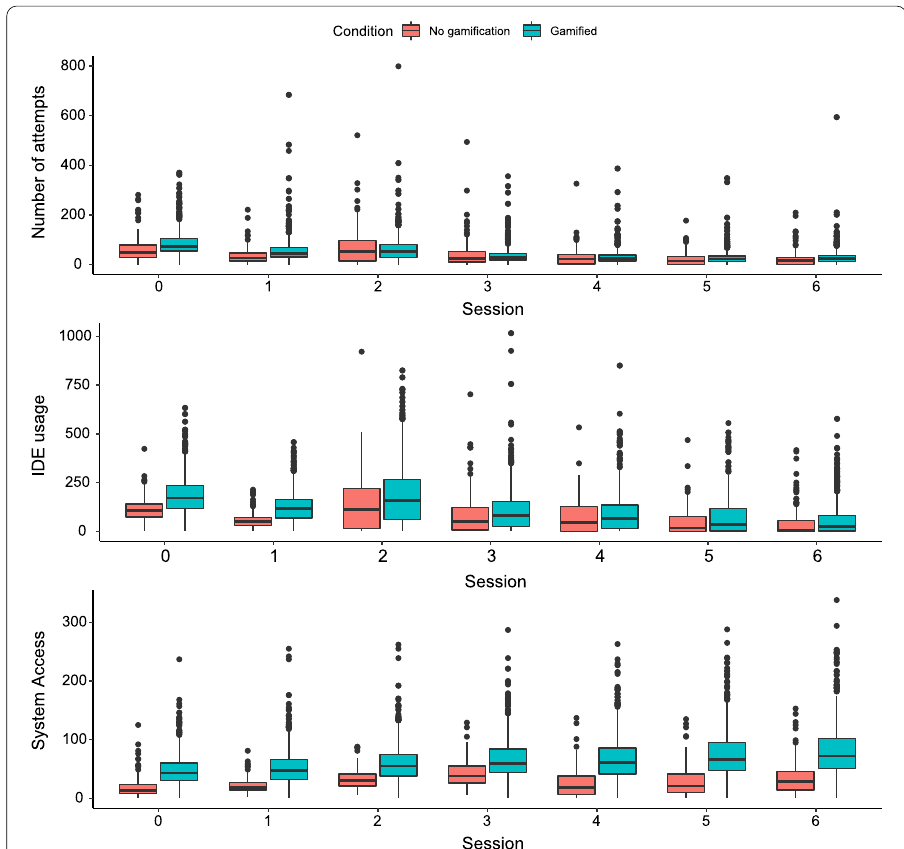
Fig. 2 Boxplots demonstrating the distribution of each behavioral measure of each condition for each session